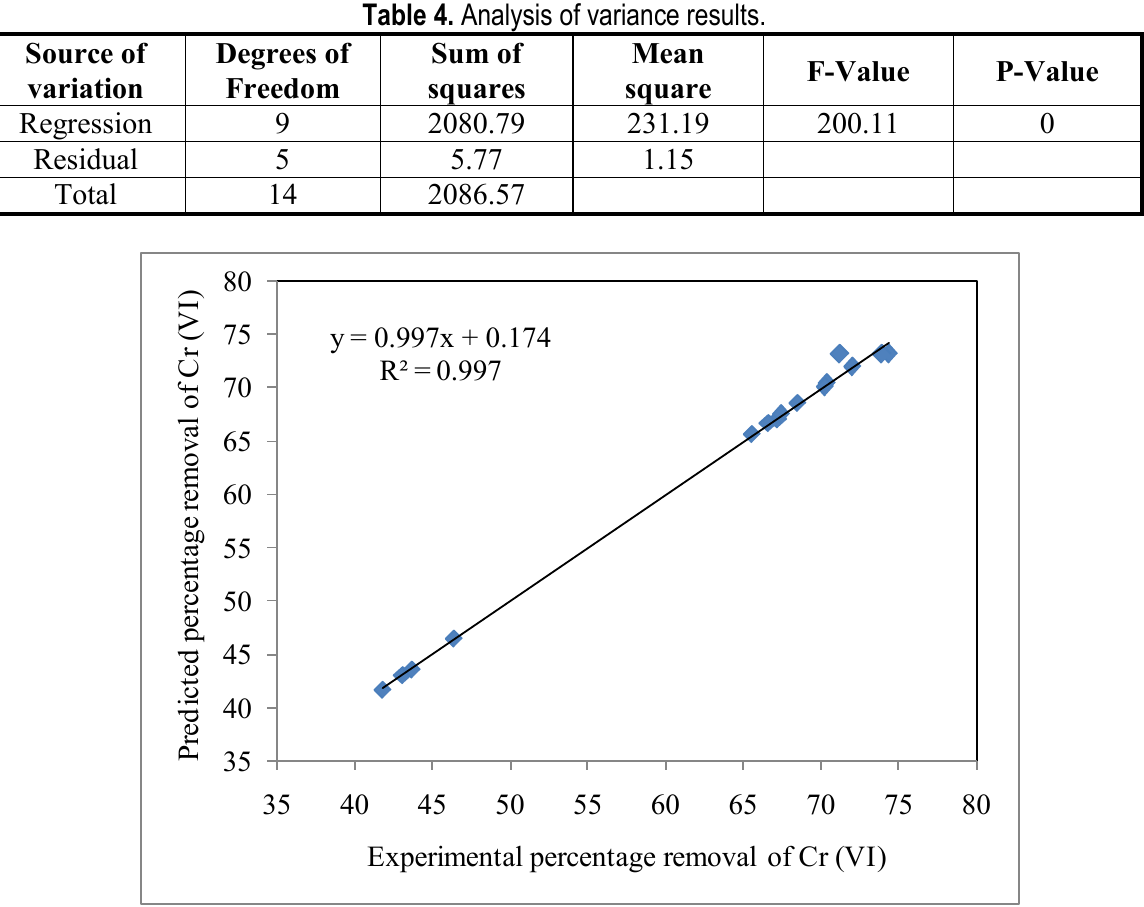
Experimental percentage removal of Cr Figure 4. The experimental values vs predicted values for the percentage removal of Cr (VI) from BBD.